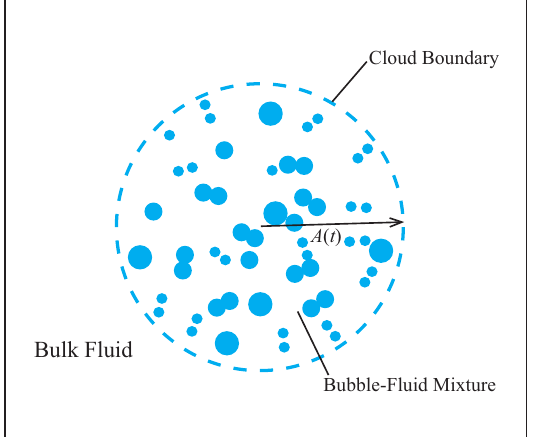
Figure 13. Schematic of the set-up of the bubble cloud Rayleigh Collapse. A spherical bubble cloud with N 0 vapor bubbles is placed inside the bulk water. A ( t ) is the radius of the bubble